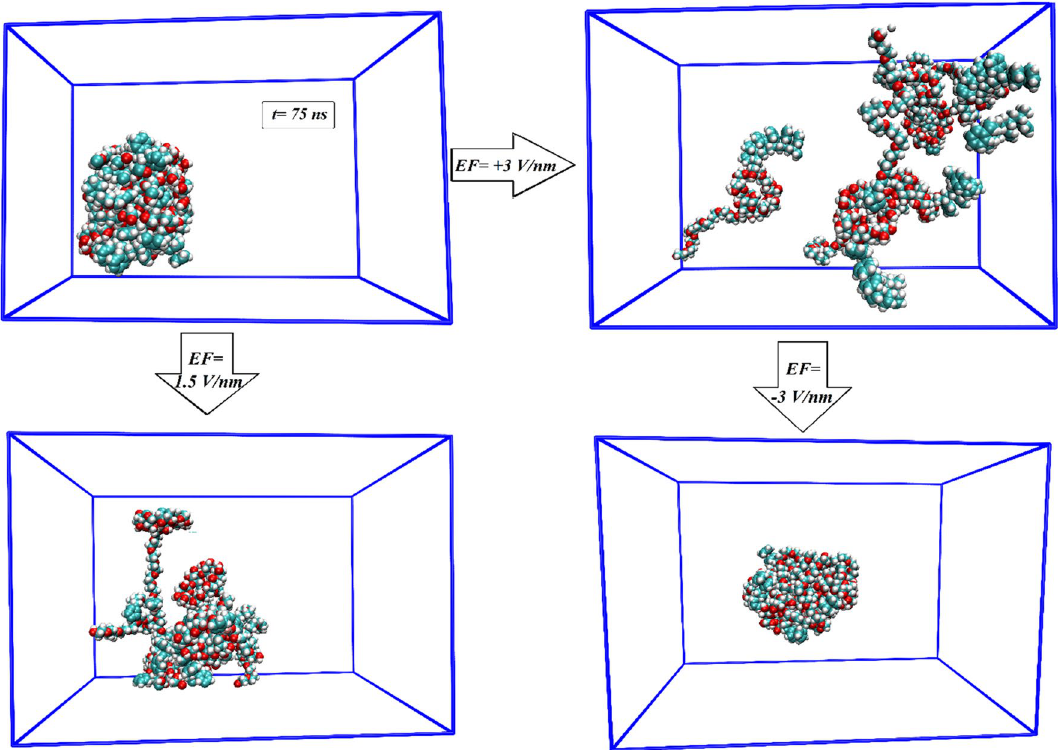
Figure 3. EF-responsive controlled assembly and disassembly of PS-β-CD/PE-FE supramolecular micelle.